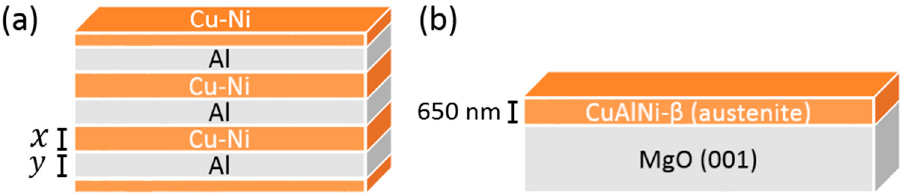
Figure 1. Sketch of the ( a ) prepared Cu-Ni / Al multilayers before quenching (for x and y values refer to Table 1) and ( b ) Cu-Al-Ni film on (001) oriented MgO. Table 1. Thickness values of the sputtered multilayers before quenching. The top and bottom Cu–Ni layers have half the thickness of the layers in between.